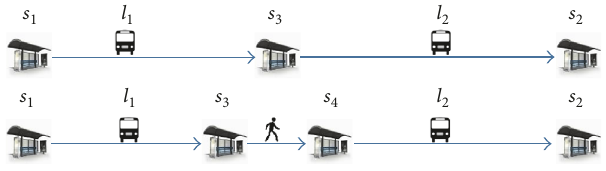
Figure 4: Illustration of routes with one